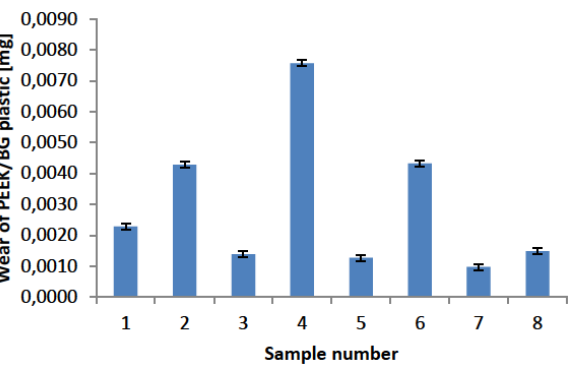
Figure 8: A bar graph of mass loss of PEEK/BG plastic